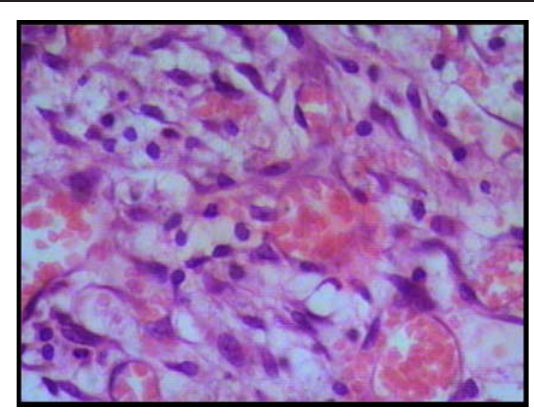
FIGURE 8 - Photomicrography with 40X lens (400X enlargement) of histological slice taken from the skin of a group D rat, stained with HE, showing detail of granulation tissue with neovessels